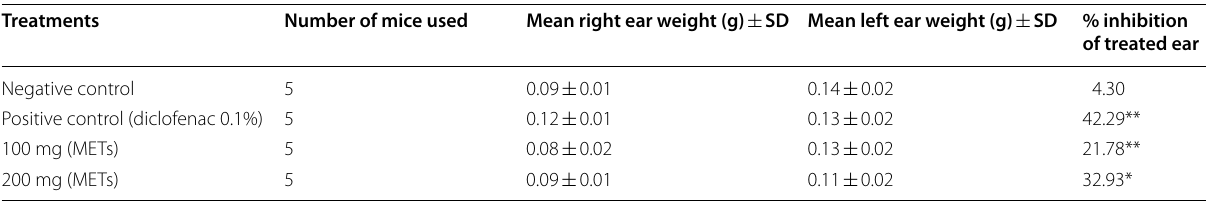
Table 6 Effect of METS on xylene-induced edema